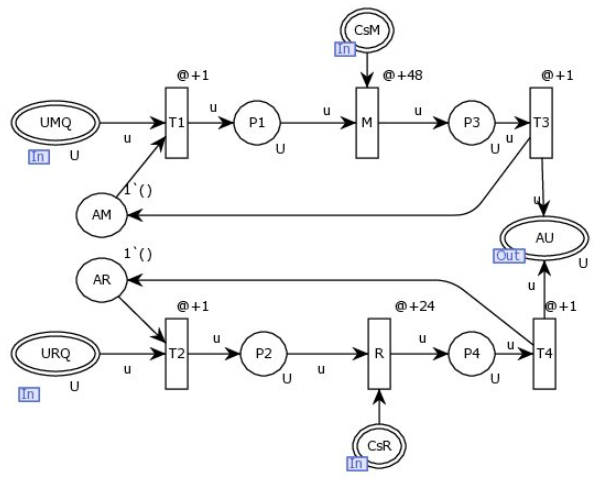
Figure 7. MR module. Figure 7. MR Table 4. Places of MR module.